Question: In a single sentence, describe what this figure presents.
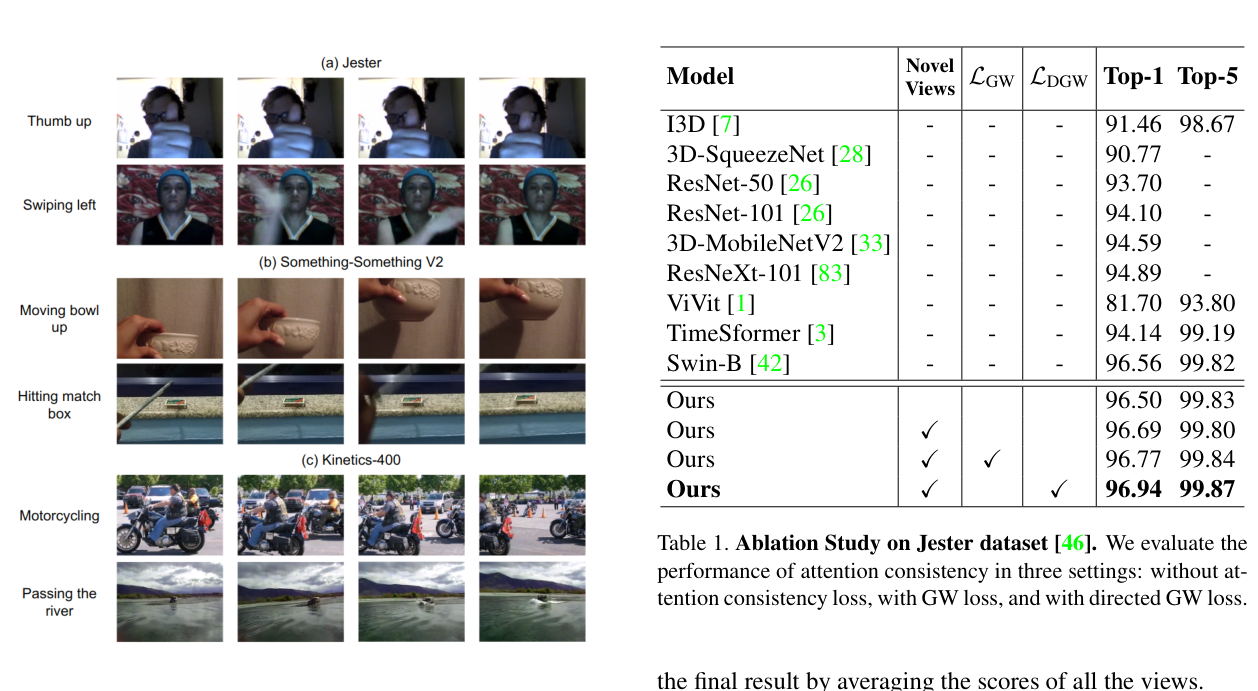
Answer: The samples of three large-scale action recognition datasets: (a) Jester [46], (b) Something-Something V2 [22], and (c) Kinetics-400 [32].